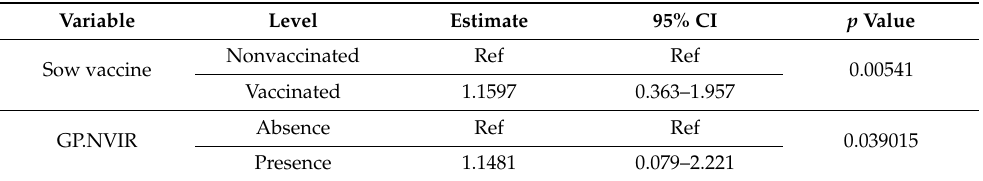
Table 4. Final model with the association of body weight of piglets after challenge and predictor variables using multivariable linear regression with repeat measurements while accounting for sow identity as random